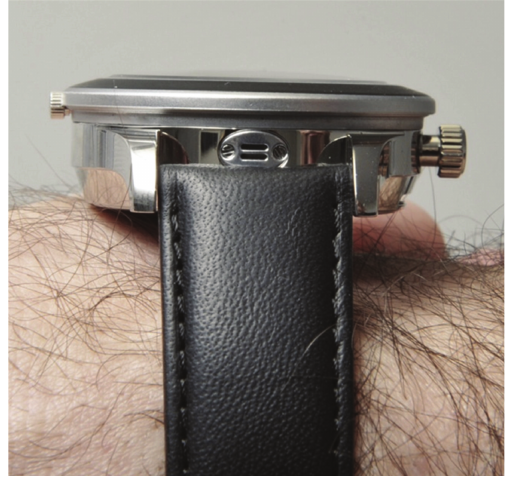
Figure 2: Limmex emergency wrist watch: wrist shot showing the dimensions of the watch and the microphone.